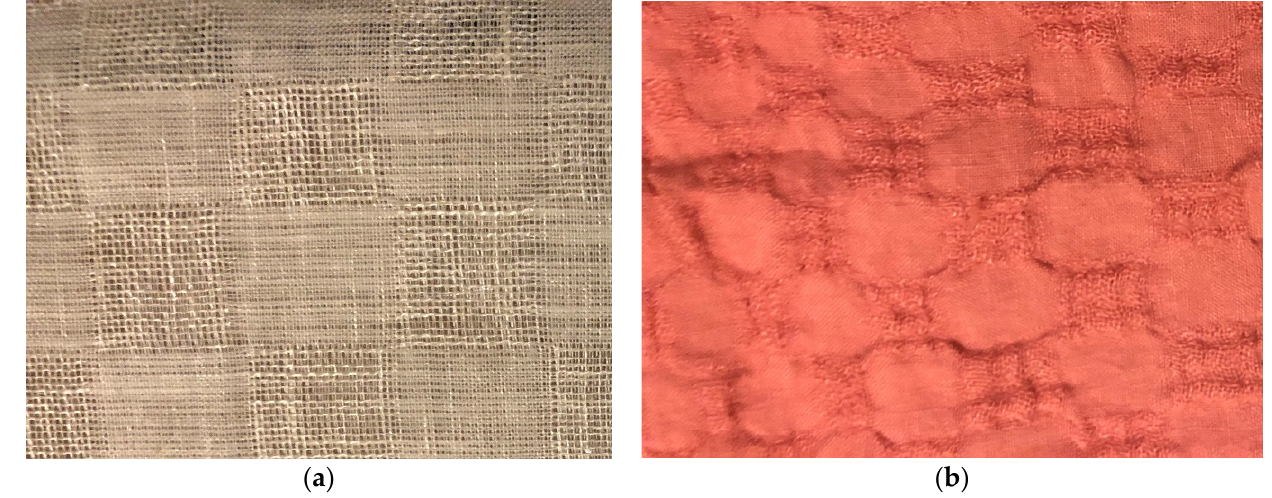
Figure 1. Images of investigated fabric: ( a ) loom state fabric; ( b ) dyed fabric.